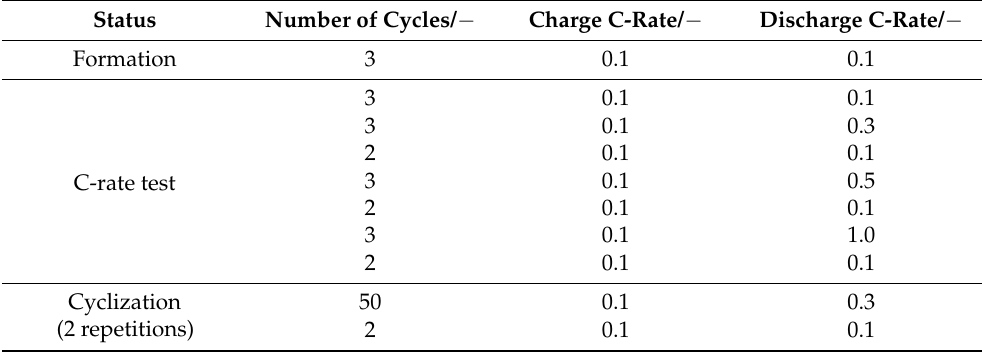
Table 2. Status, number of cycles, and C-rates during charge and discharge of the full cells for the evaluation of the electrochemical anode coating